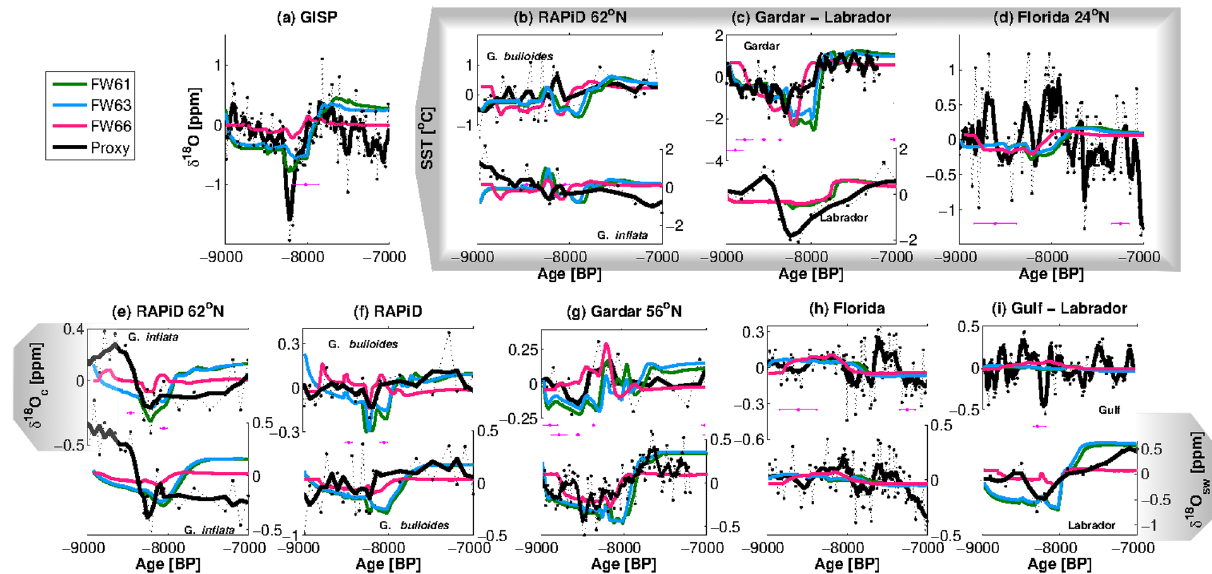
Figure 3. Comparison of simulated and reconstructed δ 18 O sw , δ 18 O c , δ 18 O ice and SST time series for the three best fitting hybrid models: RAPiD ( b , e , f ), Gardar Drift ( c , g ), Florida Strait ( d , h ), GISP δ 18 O ice ( a ), Gulf Strait δ 18 O c ( i -top) and Labrador Sea δ 18 O sw ( i -bottom) and SST ( c -bottom). Black dashed and full lines are core values and 2-points moving average. Green, cyan, and magenta lines show FW61, FW63, and FW66 simulations, respectively. The pink horizontal crosses are the dating () and dating errors ( ) for the